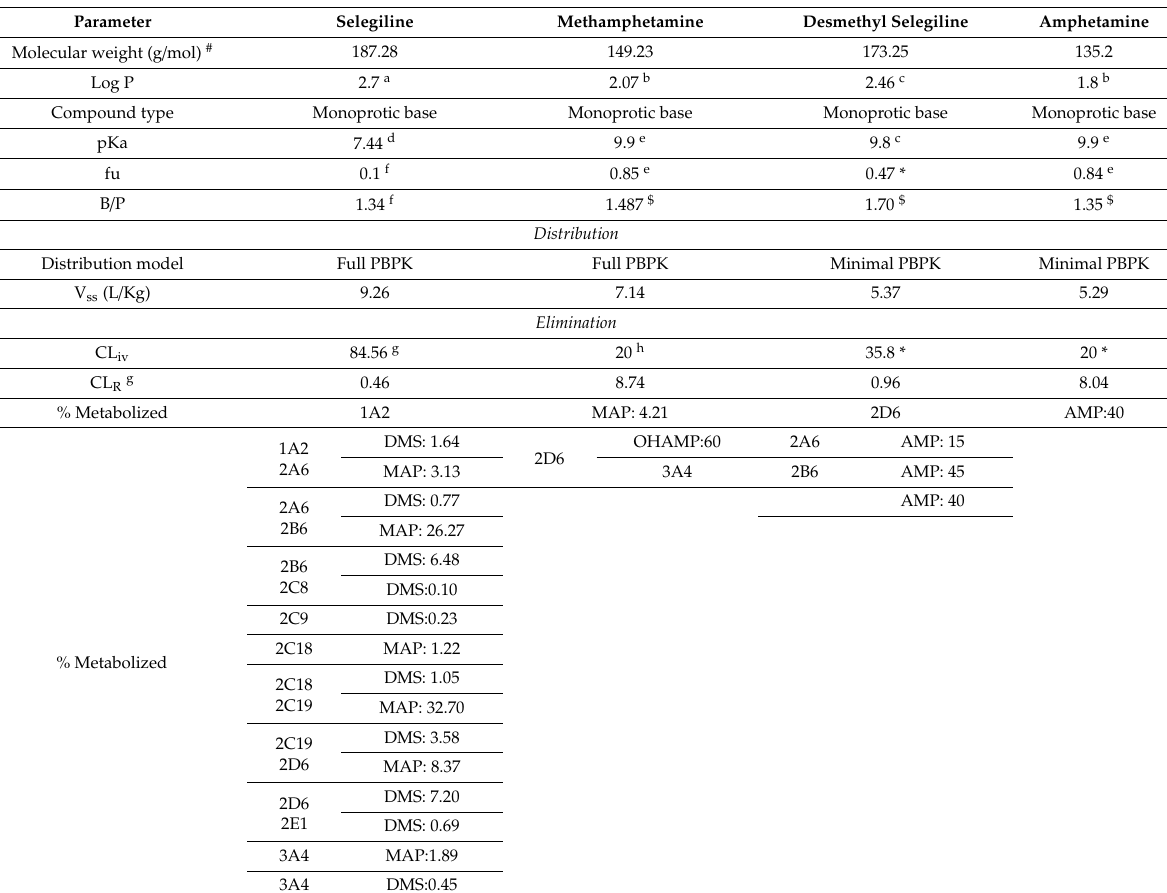
Table 1. Input parameters of SEL and its